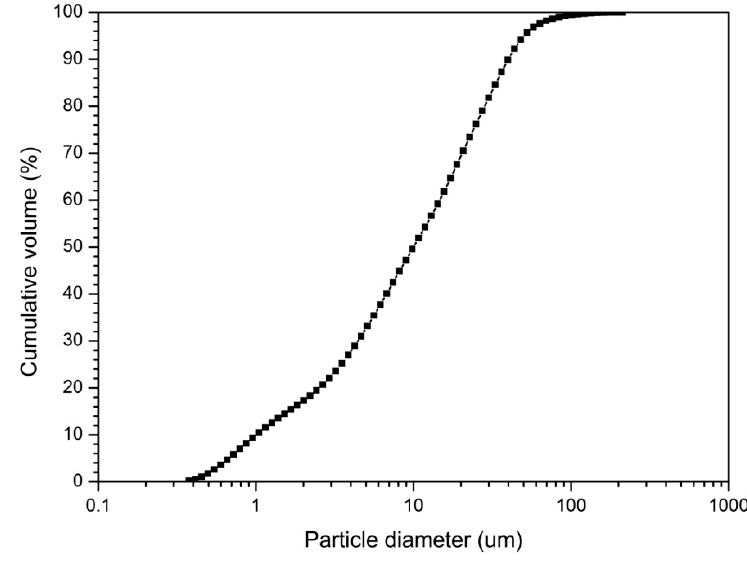
Figure 1. Particle analysis of slag.